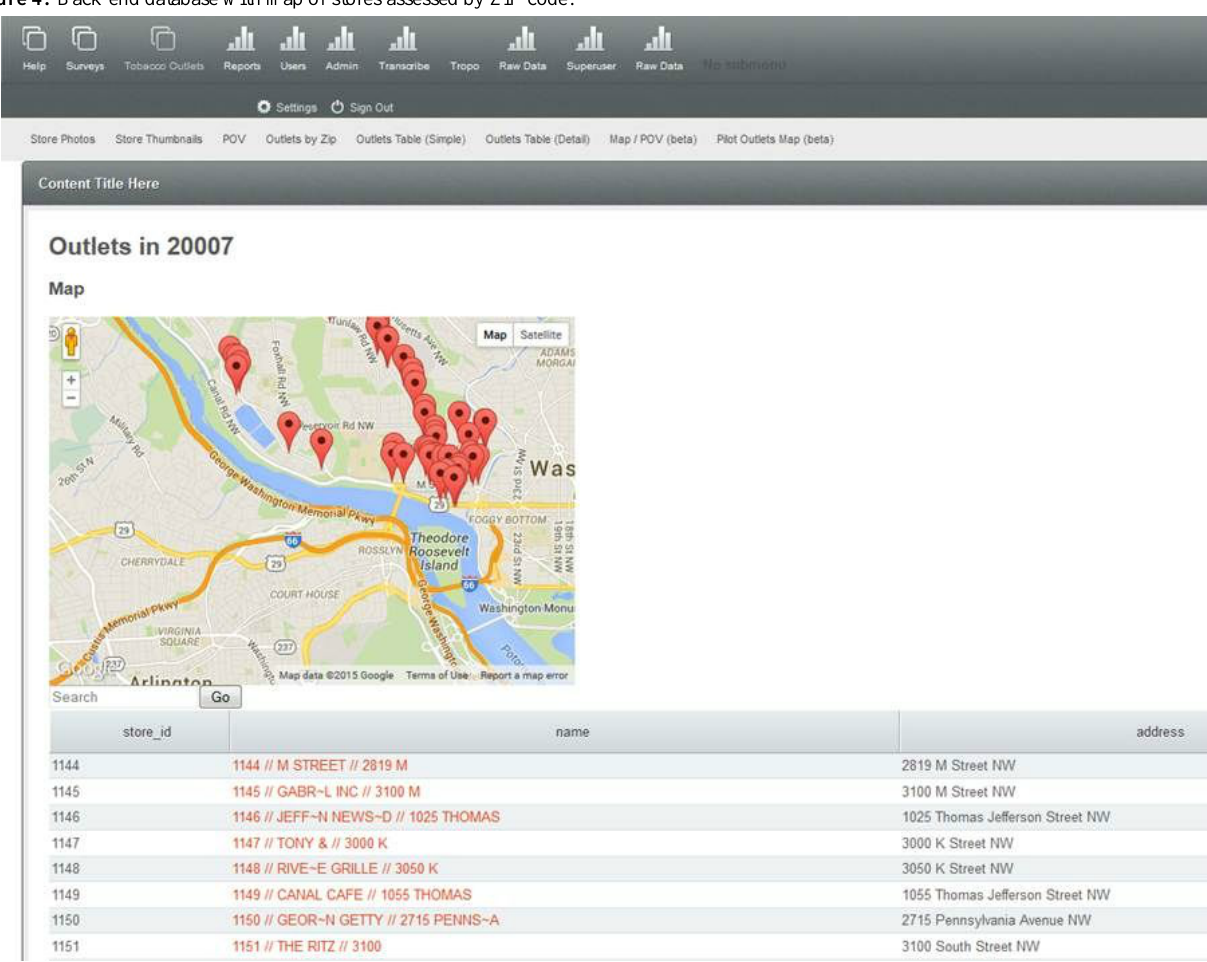
Figure 4. Back-end database with map of stores assessed by ZIP code.